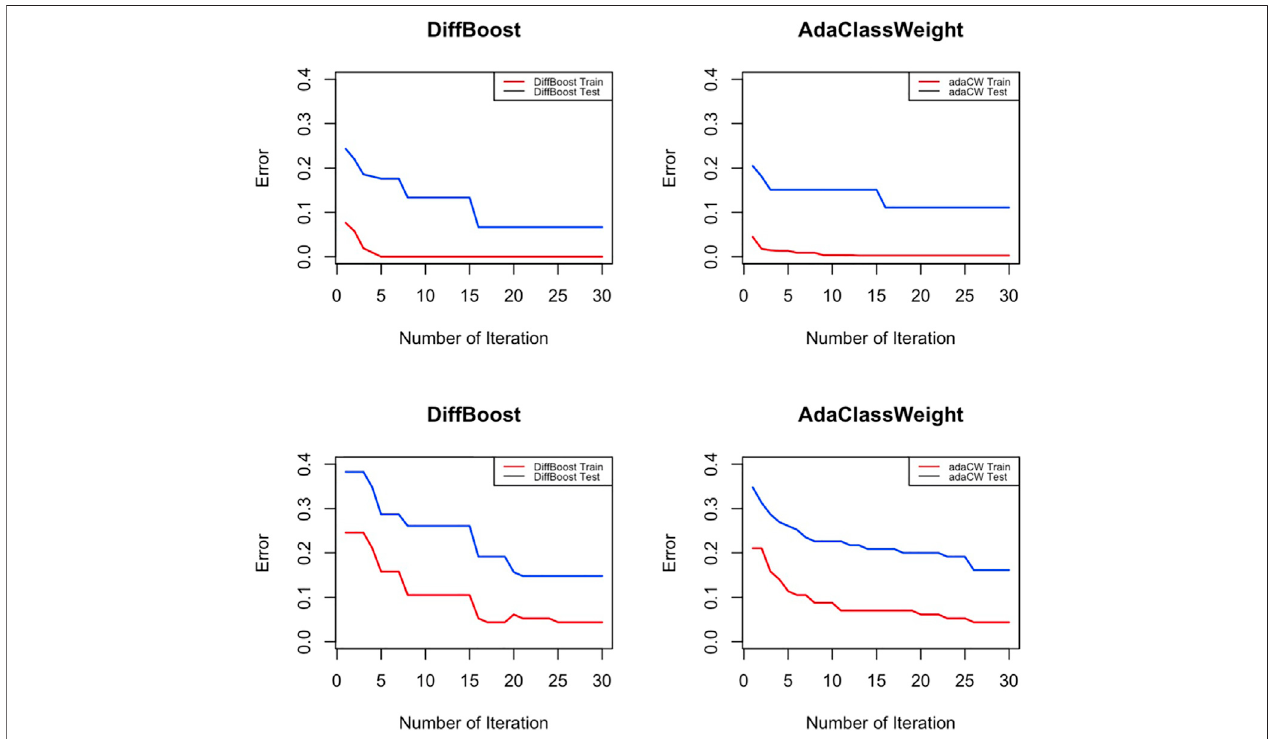
FIGURE2| Testingerroroftherareclassdecreasesalongwithtrainingerror.Inthetoprow,IEEE39-buspowersystemdataisused;Inthebottomrow,Spamdata is used.